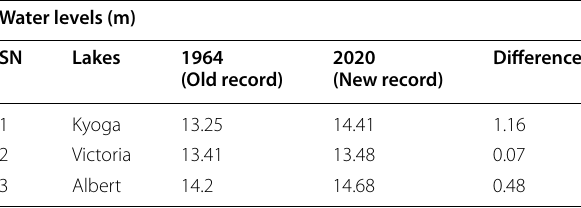
Table 3 Record-breaking water level trends for major